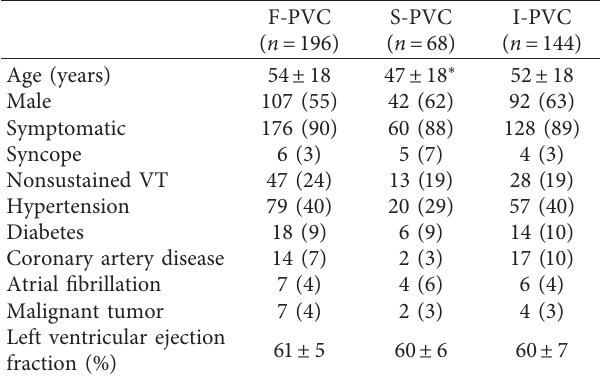
Table 1: Characteristics of patients in the retrospective